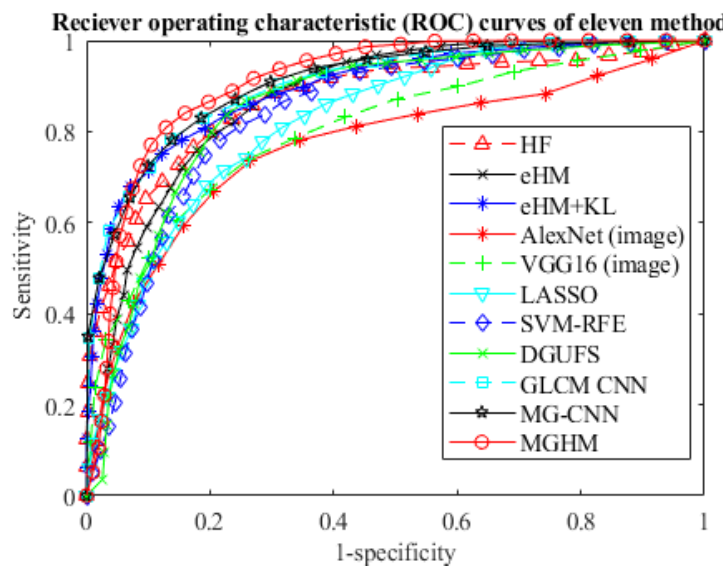
Figure 9. ROC curves of proposed and comparative methods. Table 9. p -values from statistical significance analysis over the ten methods using Wilcoxon Signed- rank Test between the predicted probabilities of these methods.